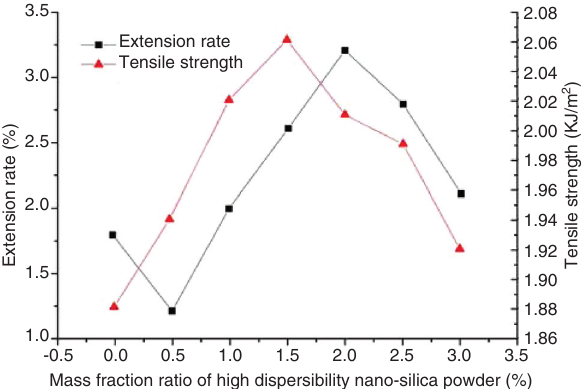
Figure 9 Contrast curve of the extension rate and impact strength as a function of the high dispersibility nano-silica powder